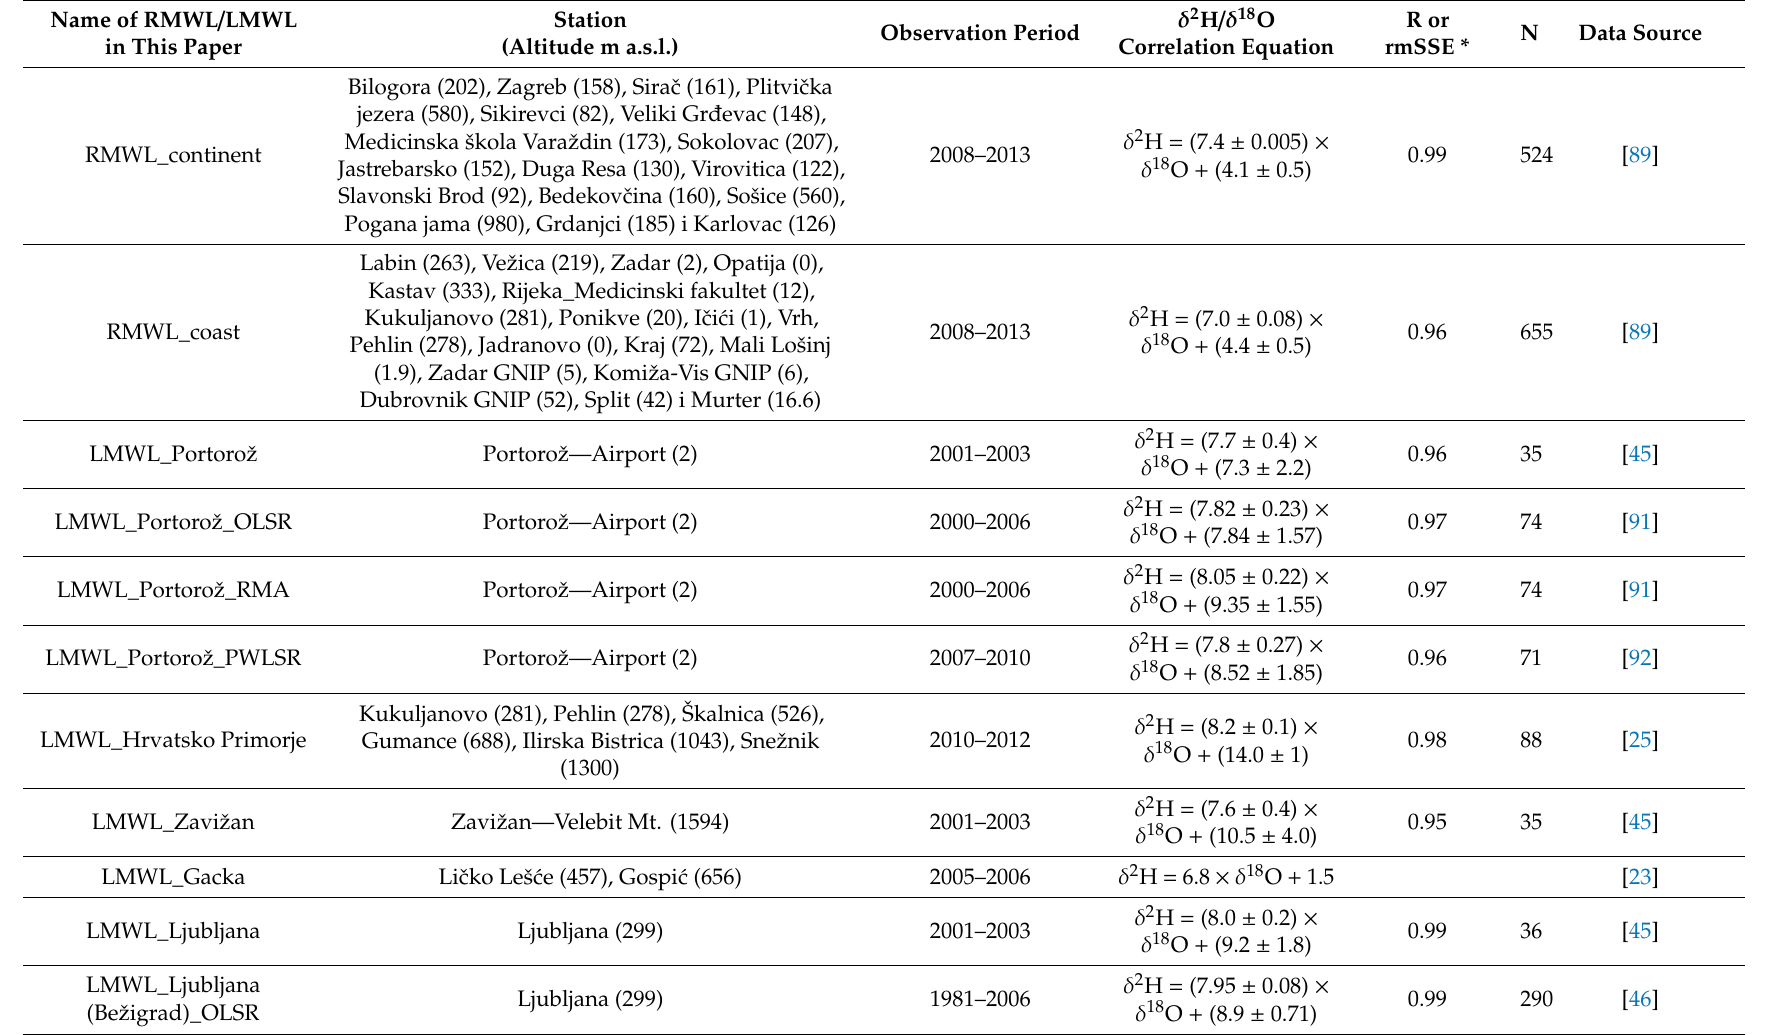
Table 3. Local meteoric water lines (LMWLs) used in this